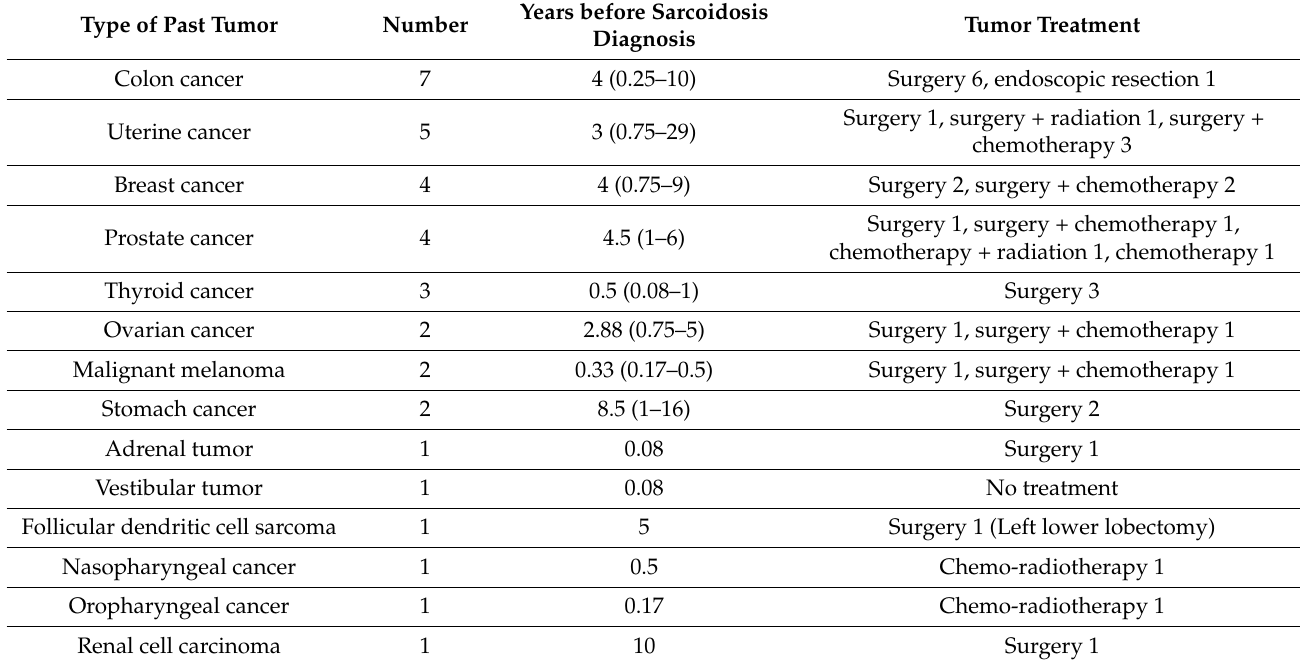
Table 4. Types of past tumors in patients with sarcoidosis.